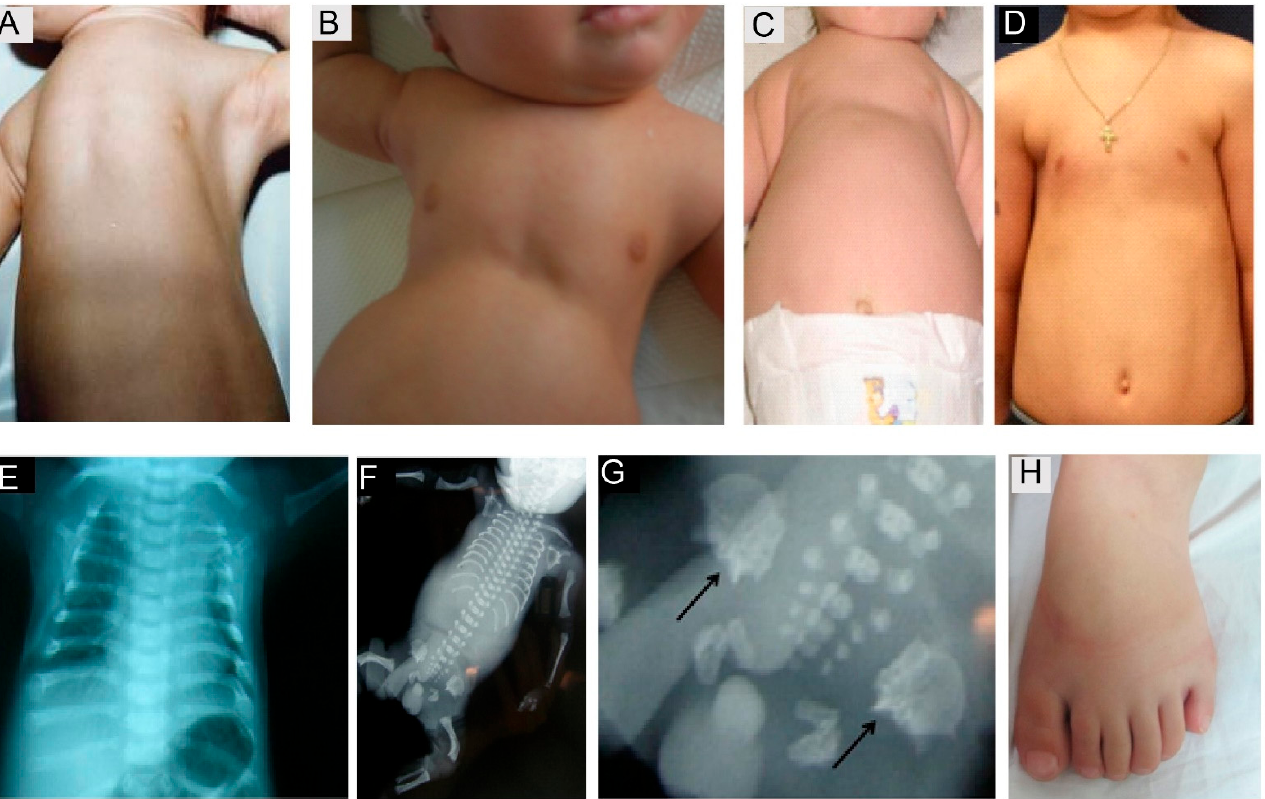
Figure 6. Skeletal features observed in short rib polydactyly syndrome patients. The main hallmark is thoracic narrowing present, observed in utero or from birth ( A – C ), becoming less pronounced with increasing age ( D ), ( E ) short horizontal ribs in a JATD case SRPS case with shortened long bones, long narrow thorax, pelvis configuration with acetabular spurs ( F , close up in G , arrows indicate spurs). JATD case with a narrow thorax and shortened ribs, as well as handlebar clavicles, shown in the thorax X-ray, ( A ) reprinted with permission from Schmidts et al. J Med Genet 2013 May;50(5):309-23 [135], ( B )